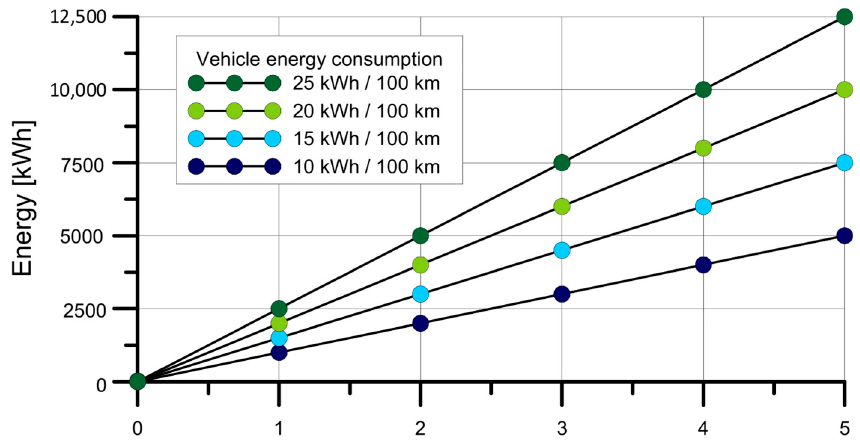
Figure 11. Demand for electricity in individual years of the vehicle at the mileage of 10,000 km/year.